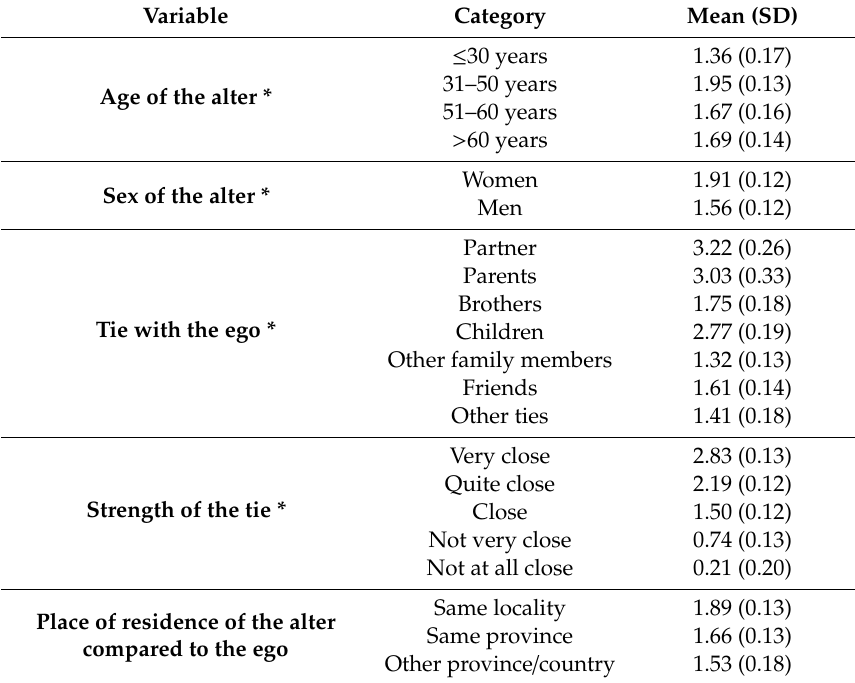
Table 1. Satisfaction and composition variables of the personal network.